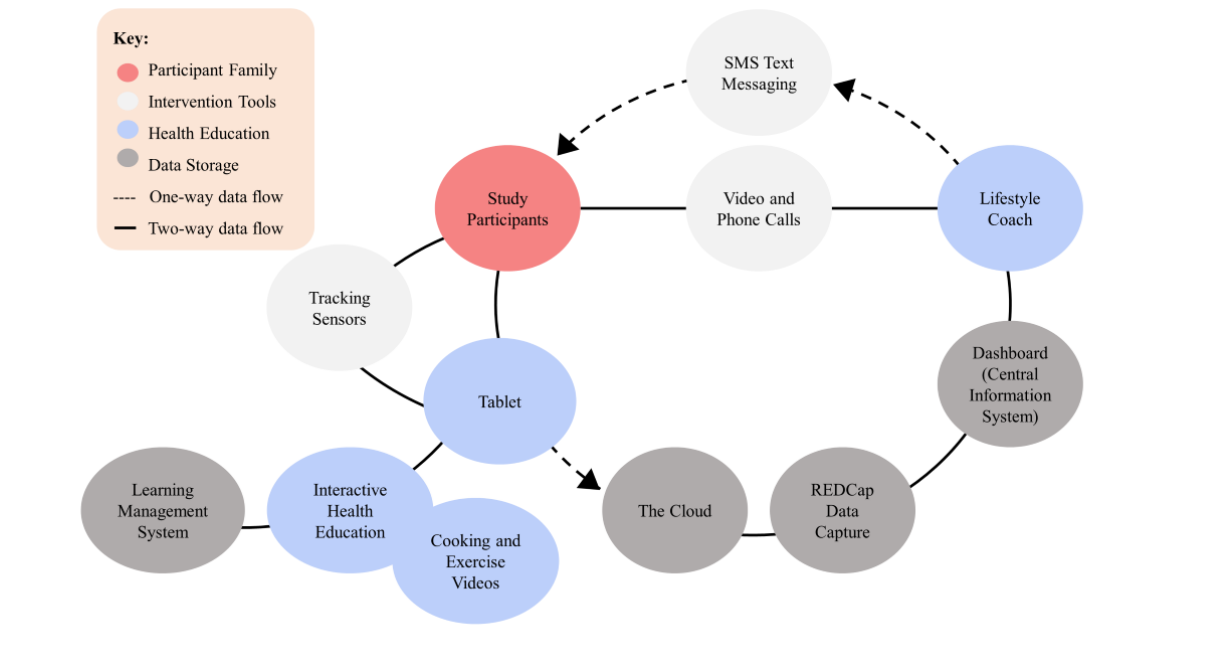
Figure 3. Healthy Frio remote technology intervention delivery